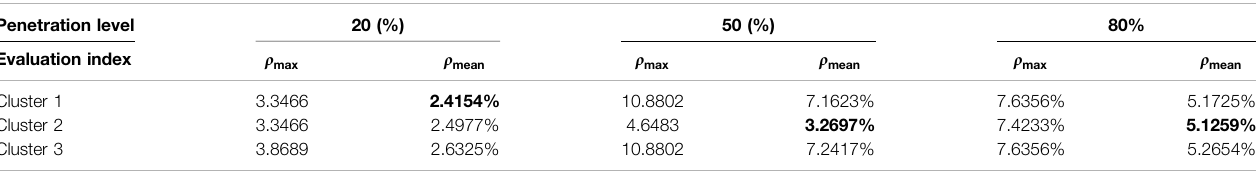
TABLE 6 | Probabilistic clustering evaluation index in each penetration level case. The minimum value for the evaluation index ρ mean. Since the cluster with the minimum ρ mean is the optimal cluster, we emphasized this with bold fonts.